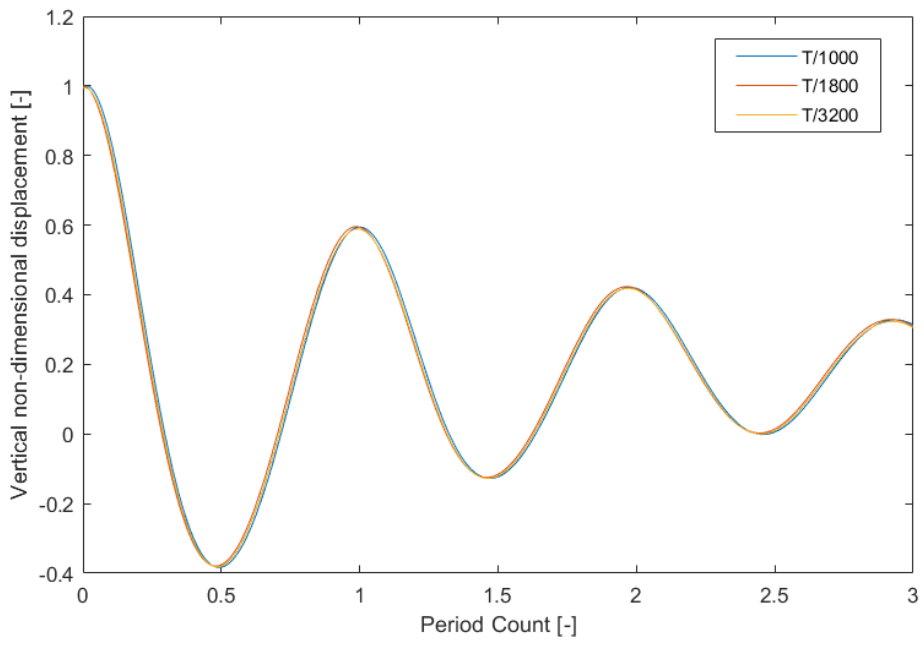
Figure 4. Signal comparison of the different time-steps used in the time dependency study.